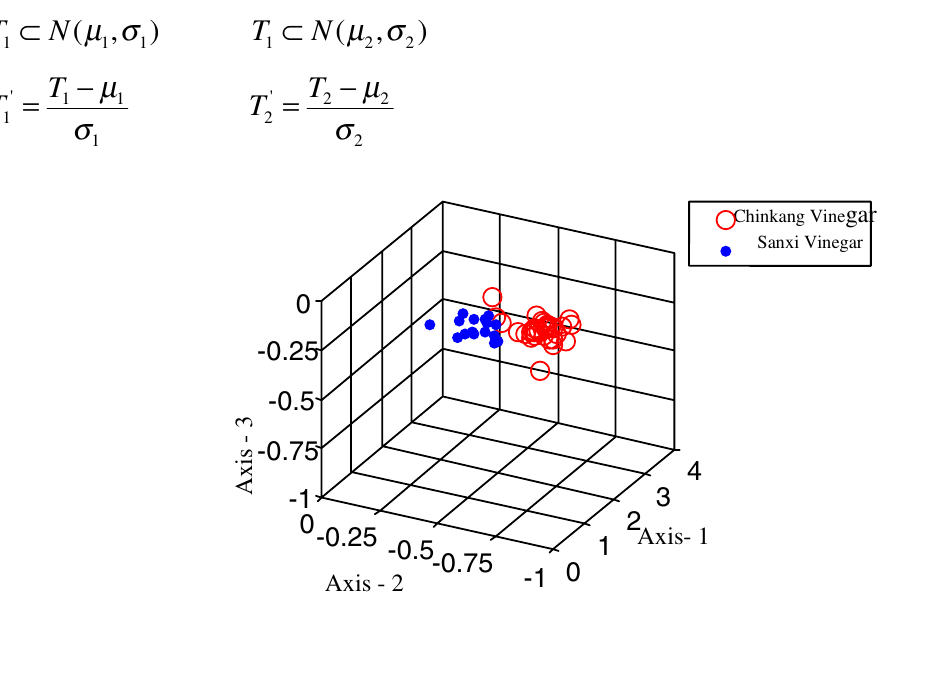
Figure 5. Results of the PCA of the gas sensor array for 40 vinegar gas samples.